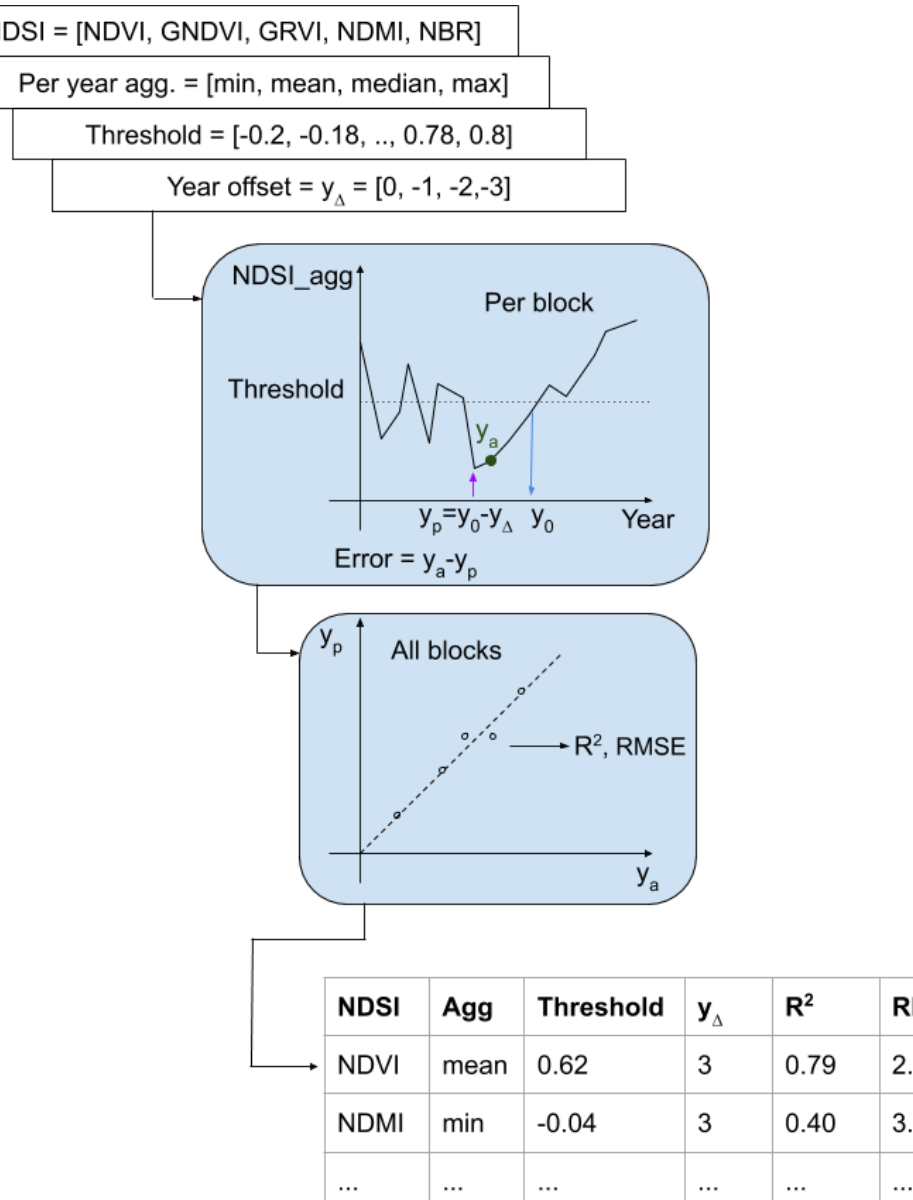
Figure 2. Search for optimal planting year prediction algorithm, by sweeping over all NDSIs, thresholds, and deltas, and finding RMSE and R 2 between predicted ( y p ) and actual ( y a ) planting